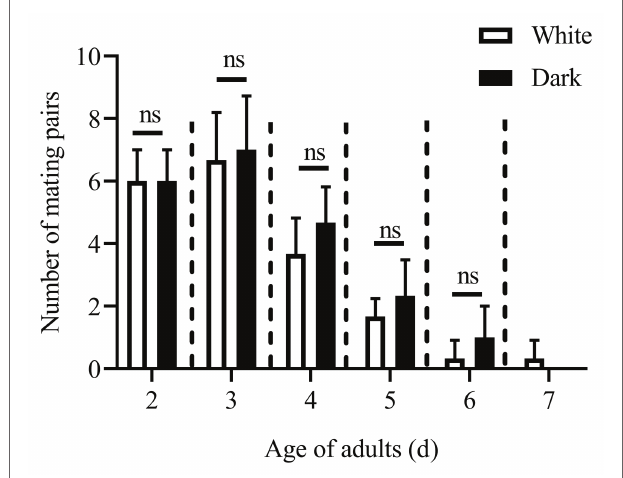
FIGURE 2 | Mating pairs of C. punctiferalis under blue light and dark conditions during scotophase. Data are shown as mean ± SD, from three replicates. Asterisks above columns mean significant differences ( ** p < 0.01, ns: no significant difference), by independent sample t -tests.